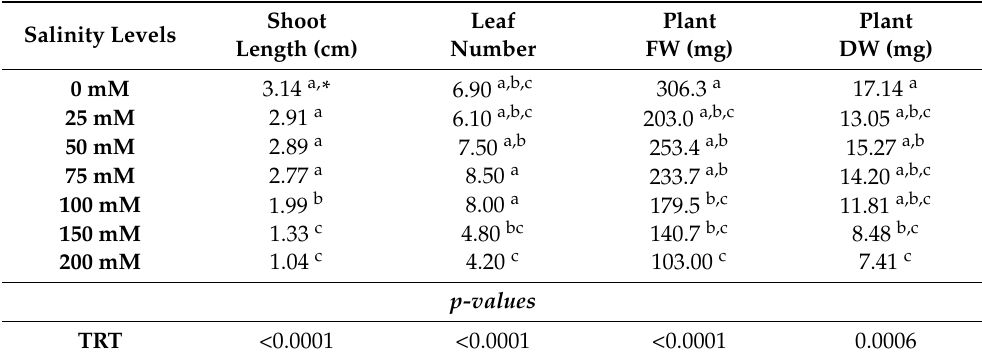
Table 3. Effect of different NaCl levels on chlorophyll content (fresh weight basis).